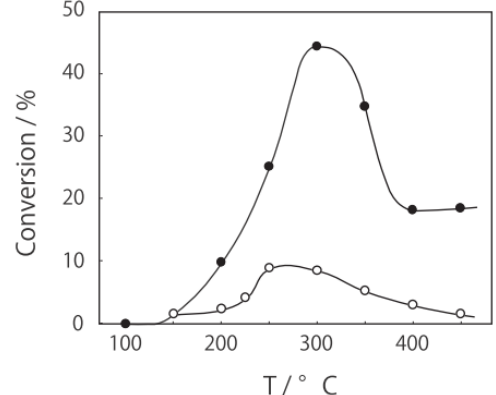
Figure 9. Effect of preliminary activation temperature and reaction temperature